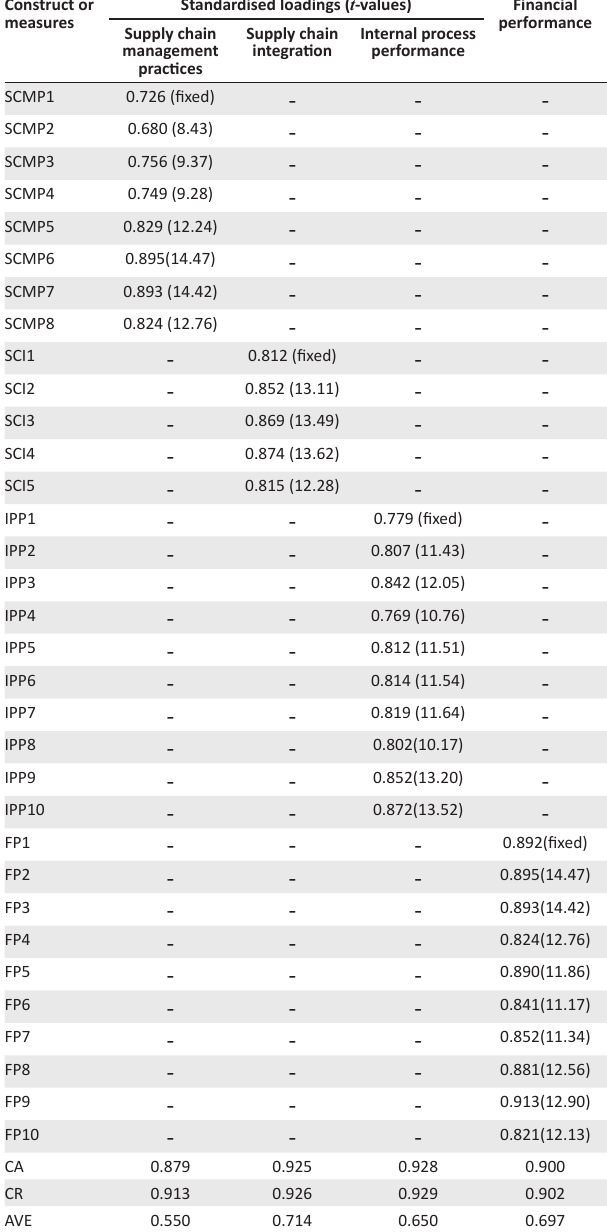
TABLE 1: Construct measures validity and reliability